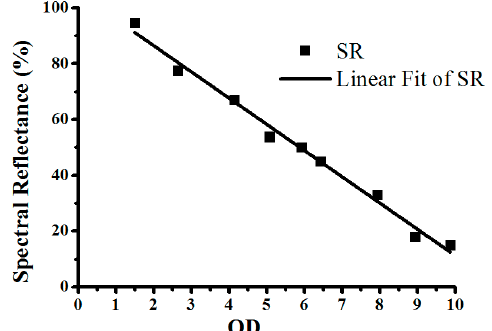
Figure 11. Linear fit of the spectral reflectance. Table 6. The calculated average spectral reflectance of the test